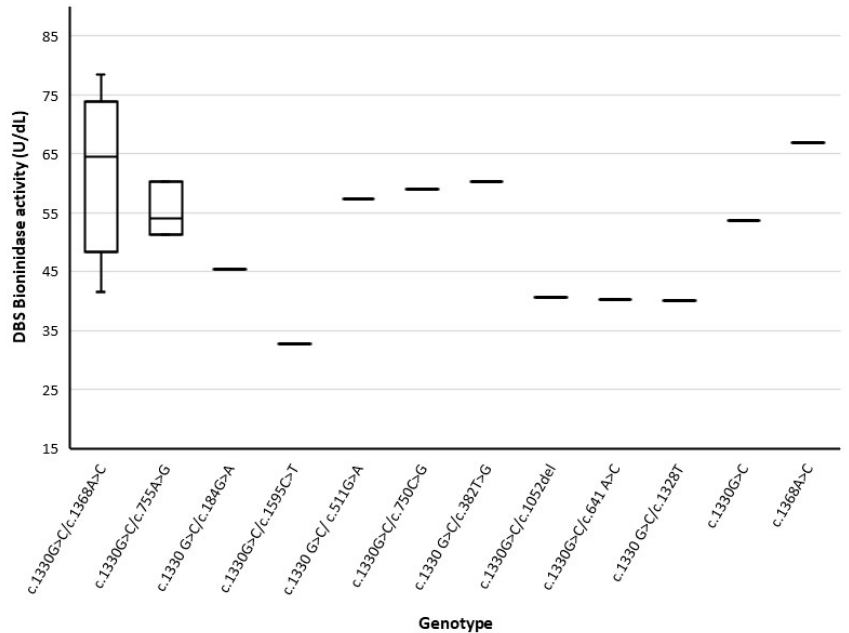
Figure 3. Biotinidase activity at the DBS screening test and variants in carriers and in affected infants.